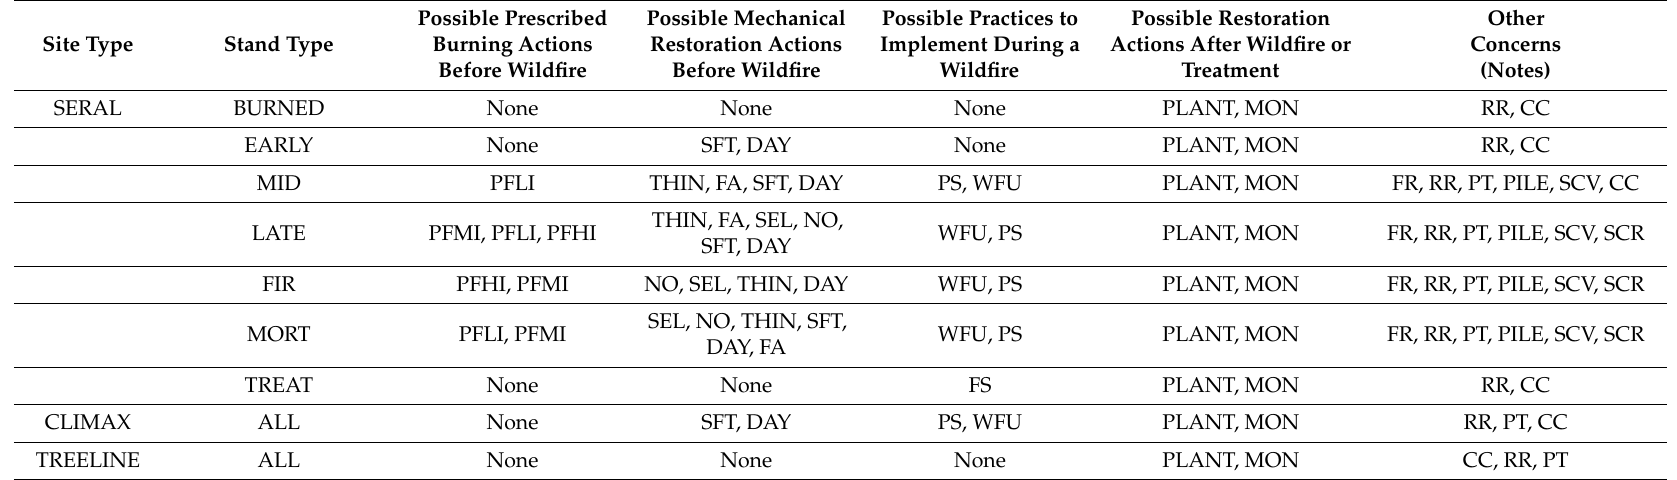
Table 1. The set of wildfire management practices and companion restoration treatments that can be implemented before, during, and after the wildfire for all geographical regions (Figure 2) by site type (Figure 3) and stand type (Figure 4). These wildfire management practices are listed in order of preference and their acronyms are defined and detailed in Table 2 along with a complete description of other concerns and the definitions of the acronyms. There are subtle differences in the implementation of these actions across geographic regions which are discussed in Table